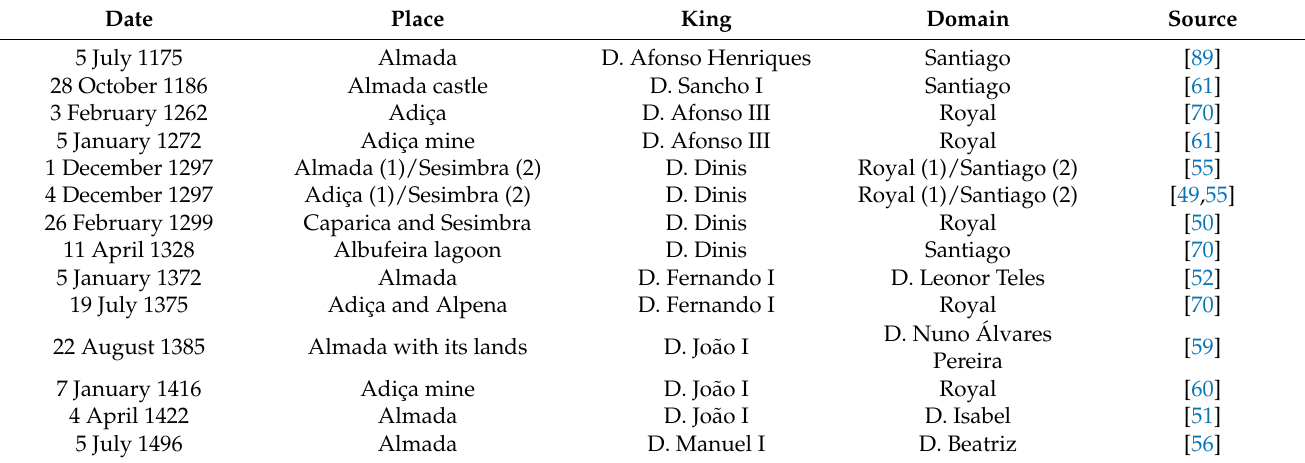
Table 1. Territory full